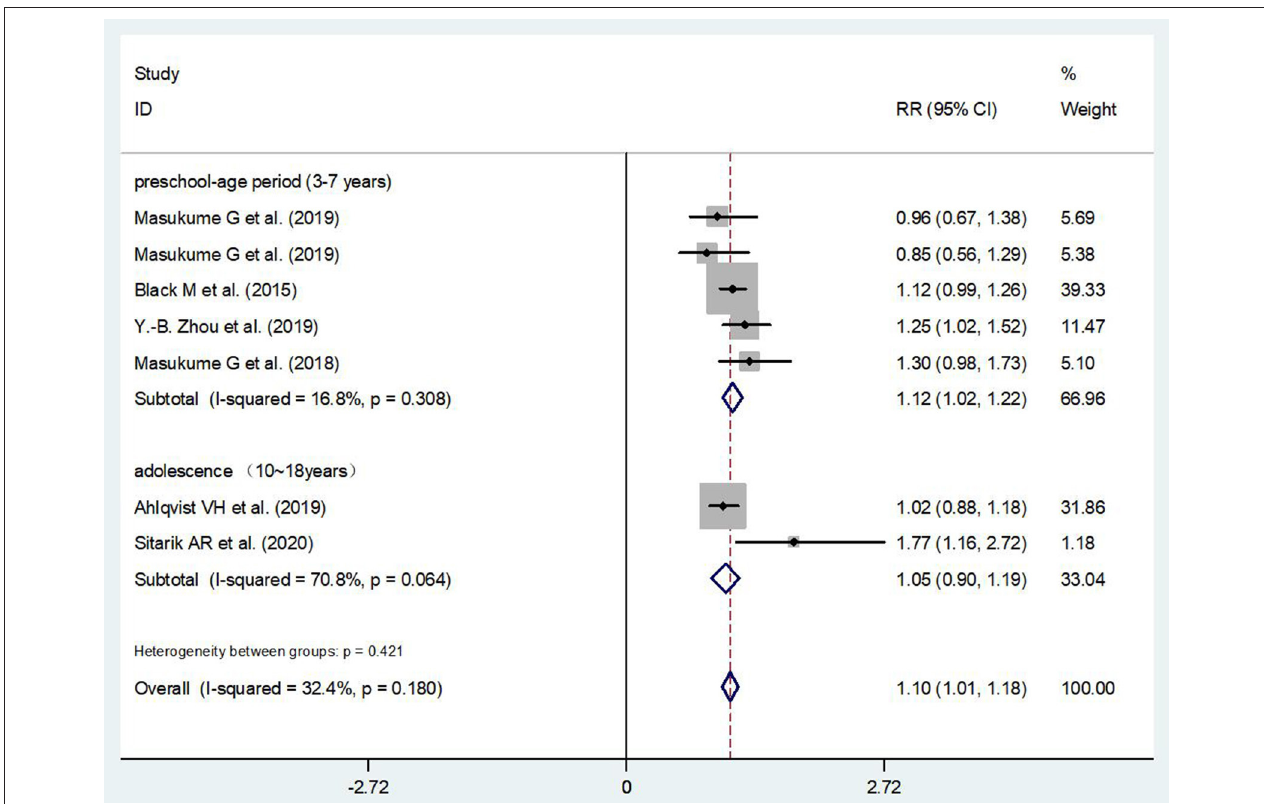
FIGURE 5 | Subgroup analysis on the association between ECS and children’s obesity stratified by